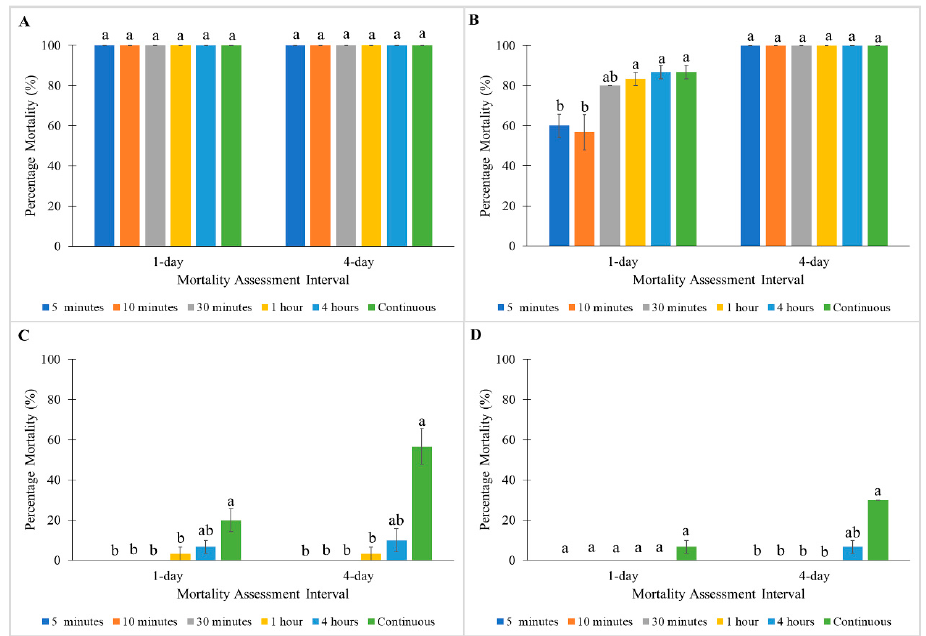
Figure 4. Influence of exposure time on Sumithrin on percentage mortalities of a susceptible C. lectularius strain and three C. hemipterus strains at 1 and 4 days post-treatment. ( A ) Monheim, ( B ) Madam Mo, ( C ) Tanjong Tokong, ( D ) Green Lane strains. Bars with different letters are significantly different (Kruskal–Wallis test, p < 0.05).